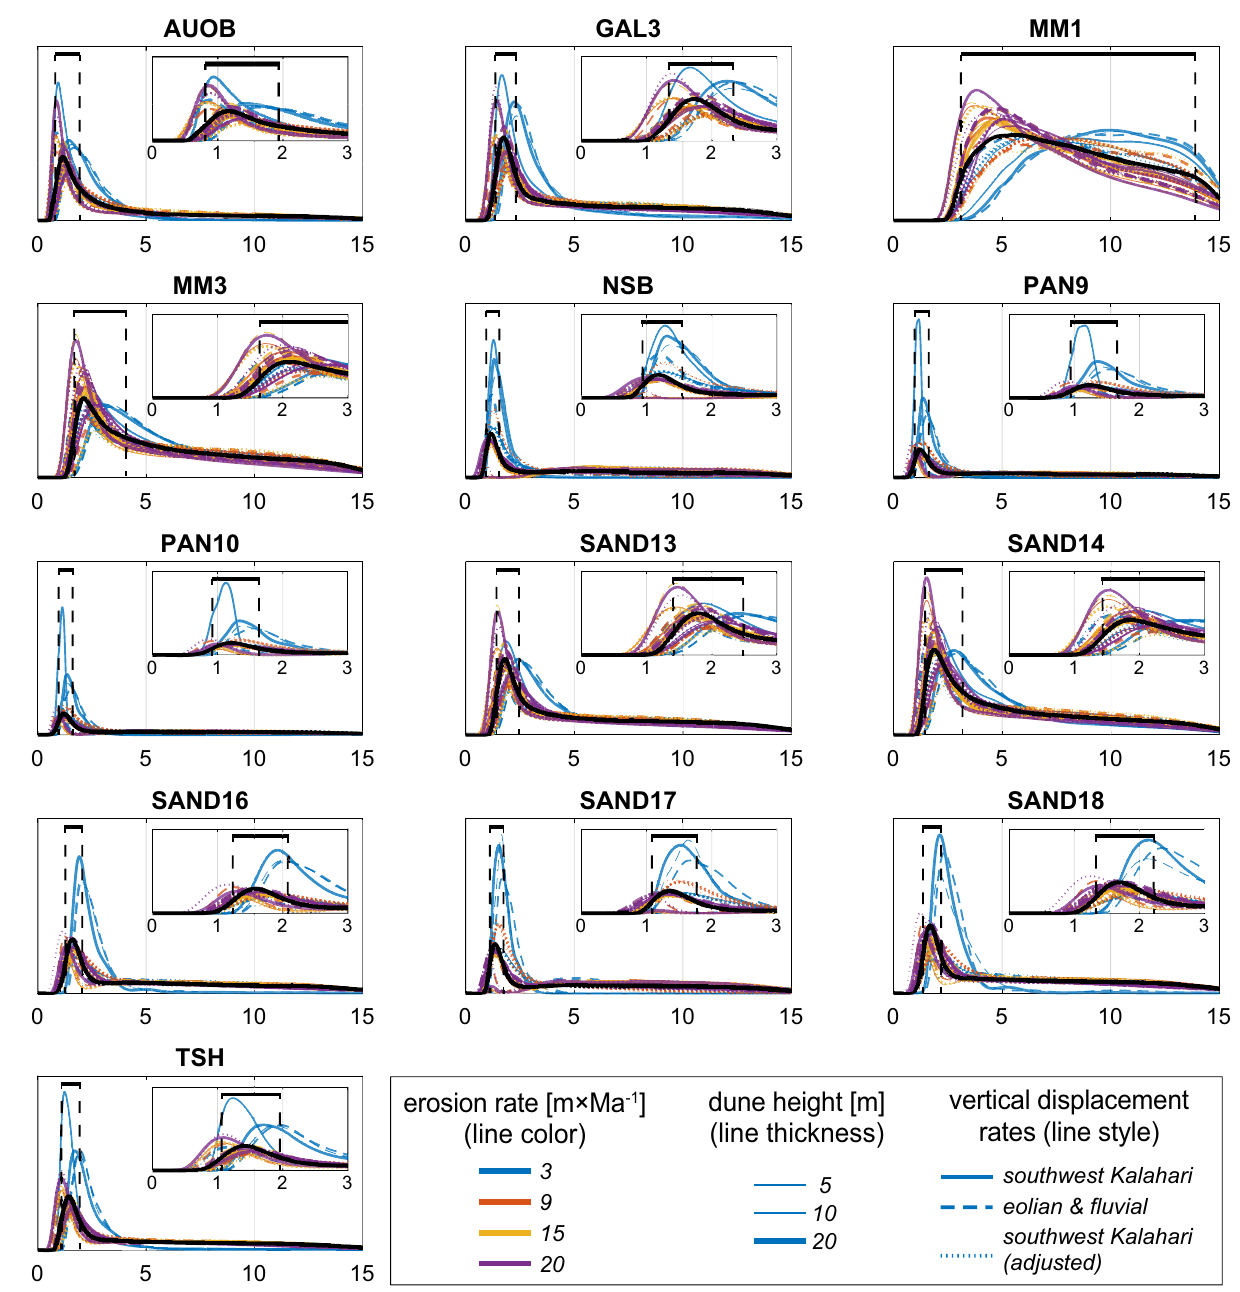
Fig. 2 | Kernel density estimates of simulations performed to assess eolian residence time of Kalahari Sand. Simulations were carried out using the Cos- molianprogram 27 inwhichmodeledconcentrationsof 26 Al 10 Be simulatedmeasured valuesinKalahariSandsamples.Resultsaretheoutcomeof10,000simulationsfor each of the 36 combinations of parameters representing possible scenarios con- sidered for each sample. These boundary conditions include four paleo-erosion rates, three dune heights, and three datasets of vertical displacement rates